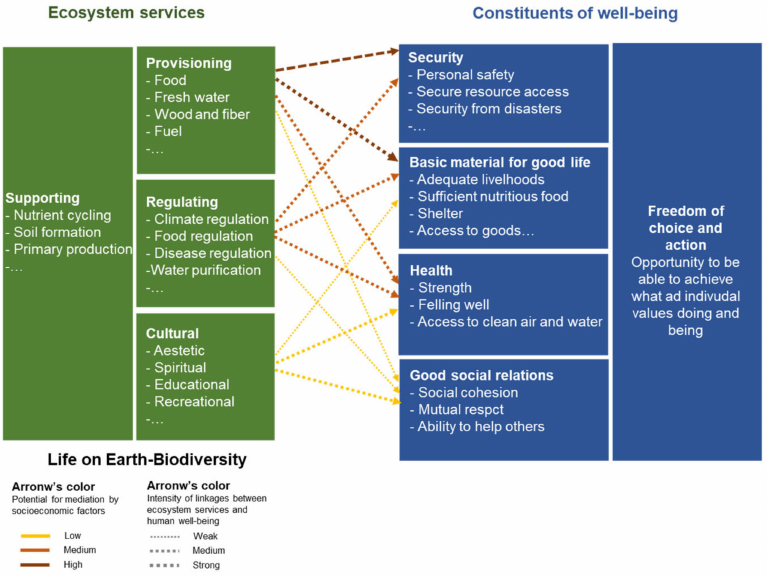
Figure 3. Linkages between ecosystem services and human well-being (our processing based on Millennium Ecosystem Assessment (MA)